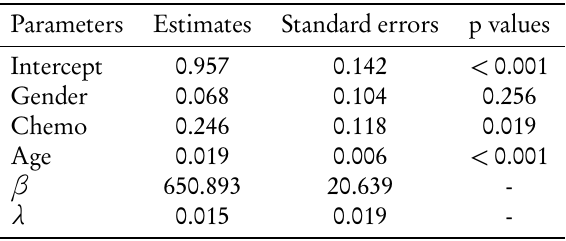
Estimated parameters of the QMOEUGD regression model.